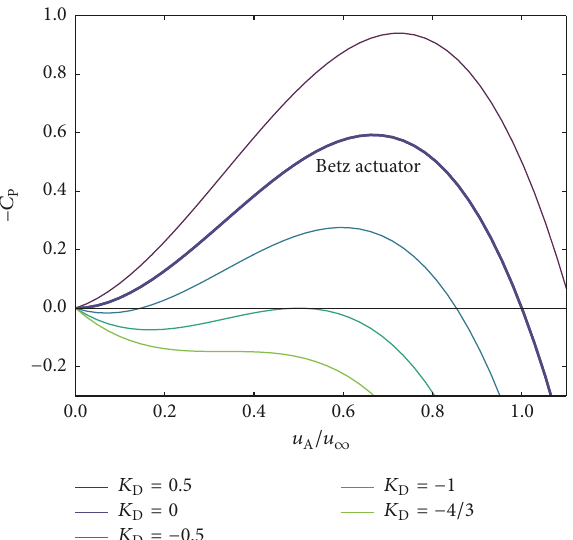
Figure 6: Power curves for an ideal actuator surface machine, for = 0 corre- different values of the drop coefficient 𝐾 . The case 𝐾 D D sponds to the well-known solution for an actuator surface without any loss, now associated with Betz and Joukowski. Positive values of 𝐾 correspond to increased pressure drop across the device; D increasingly negative values of 𝐾 may occur due to increasing D > 0 , above the pressure losses. Note that negative 𝐶 values (or −𝐶 P P straight horizontal line in this figure) correspond to hydraulic power being extracted by the device, which is obviously the